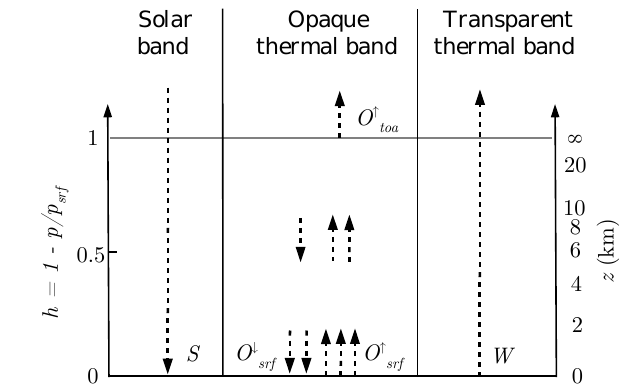
Figure 3. Sketch of the window-grey atmosphere model. S : solar radiation absorbed at the surface. O : radiation in the opaque LW band ( ↑ : upwelling, ↓ : downwelling, srf: surface, toa: top of the at- mosphere). W : radiation emitted from the surface in the transparent LW band (atmospheric window). p : pressure. Interpreting the num- ber of arrows in the opaque LW band as proportional to the radiative flux, the illustrated case corresponds to an equilibrated atmosphere with α o =